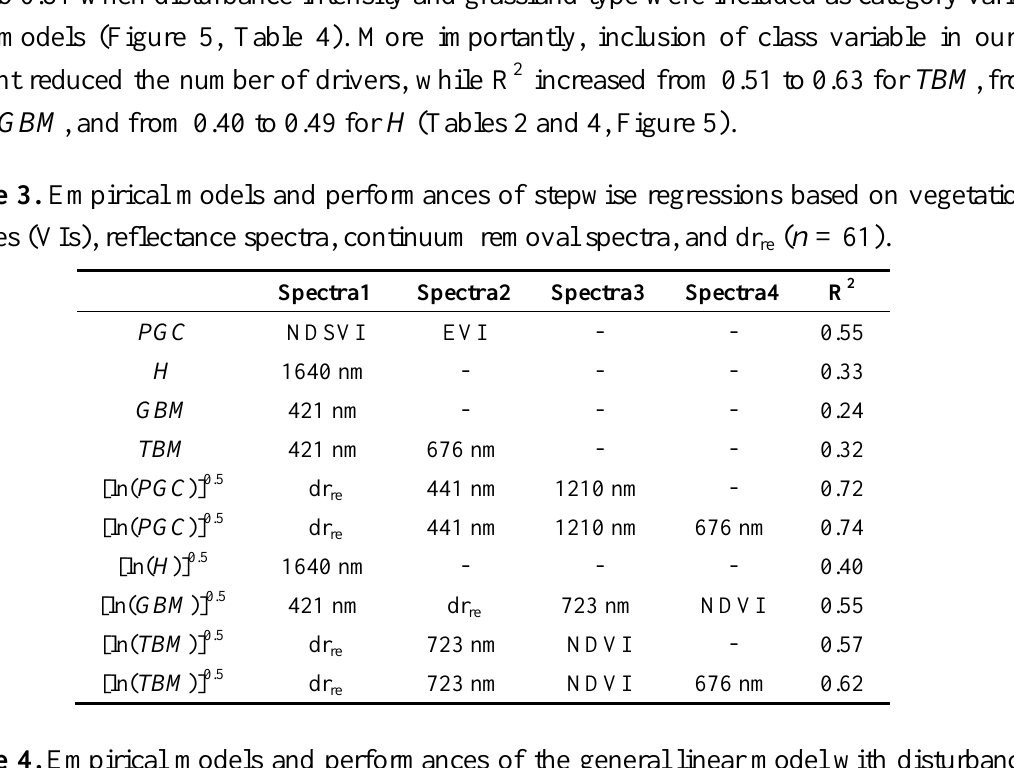
Table 3. Empirical models and performances of stepwise regressions based on vegetation indices (VIs), reflectance spectra, continuum removal spectra, and dr